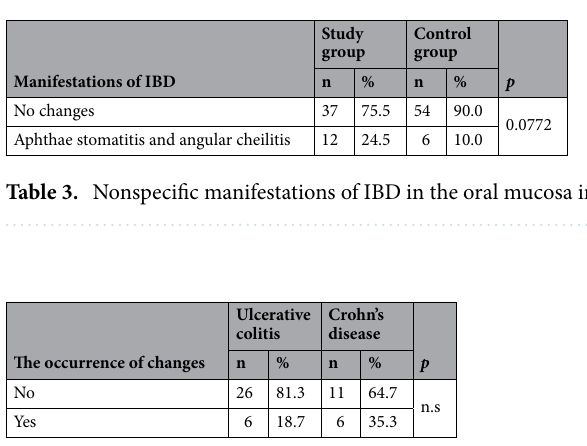
Table 4. Frequency of occurrence nonspecific of IBD oral changes in the study group.